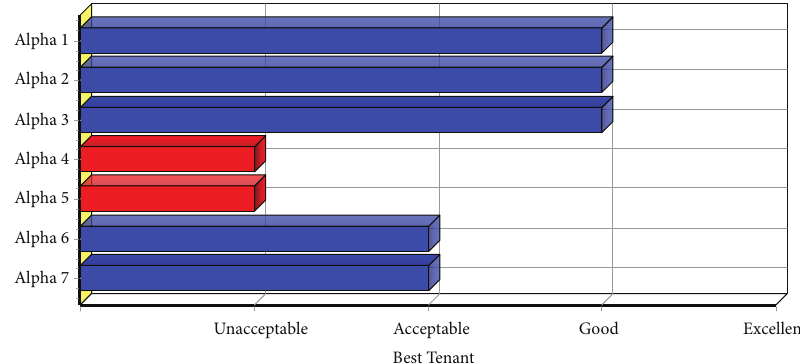
Best Figure 9. Overall evaluation of the Alphas